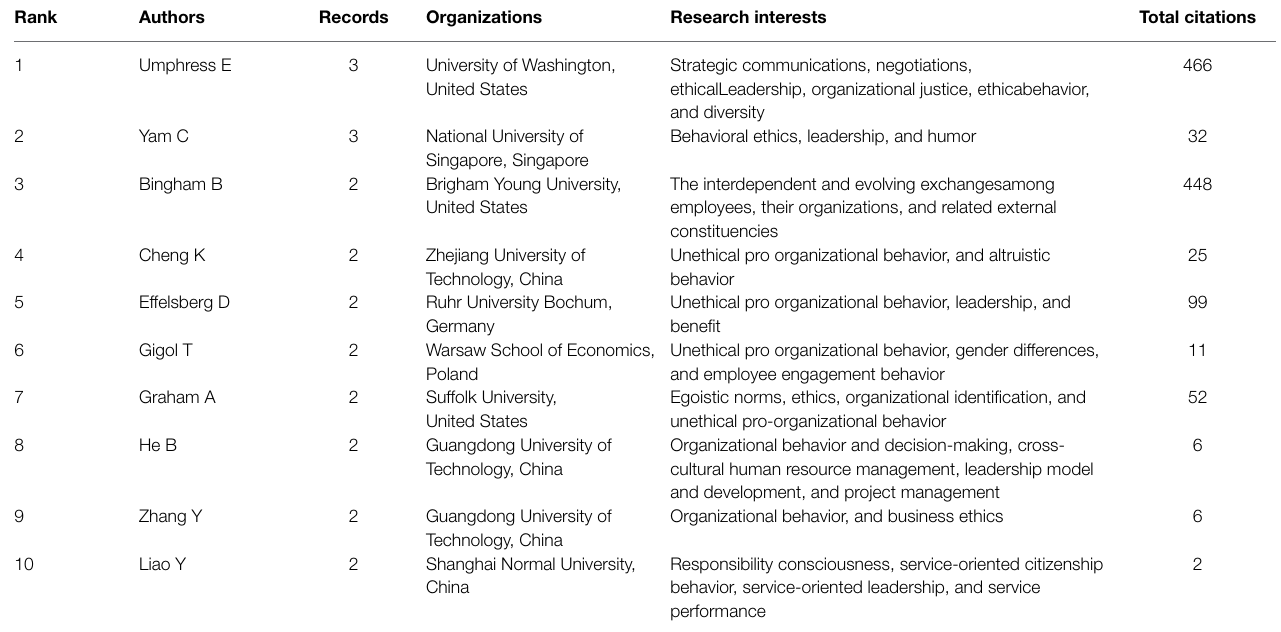
TABLE 2 | The top 10 most productive authors in UPB